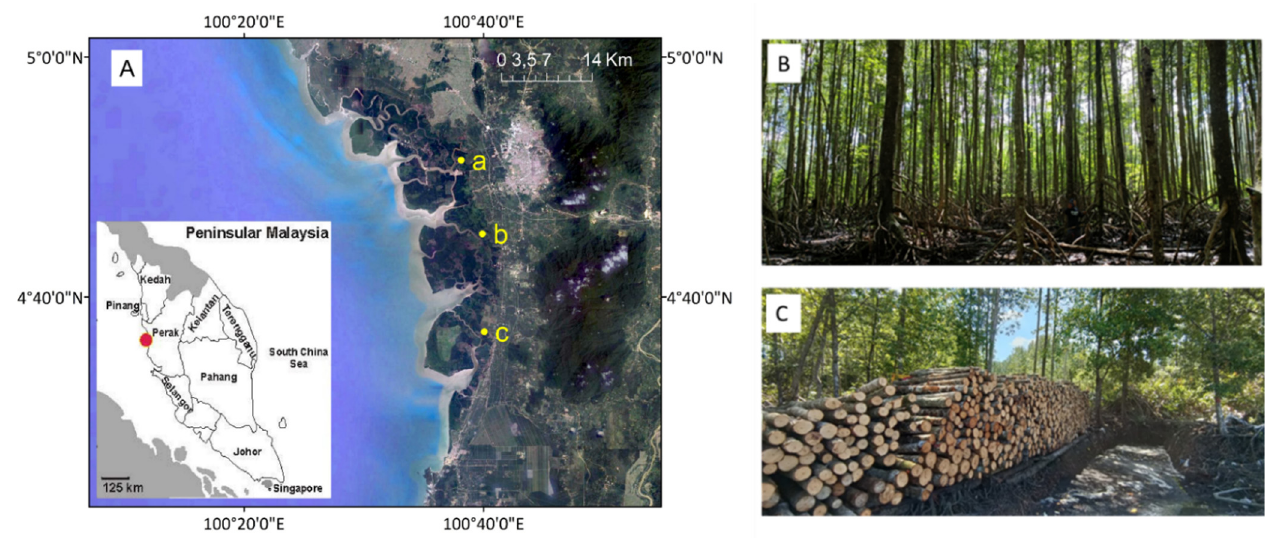
Figure 1. ( A ) Map of the Matang Mangrove Forest Reserve indicating the location of the 3 districts of Kuala Sepetang (a), Kuala Trong (b), and Sungai Kerang (c) where the charcoal factories are located. Map source: Google Earth (2018). ( B ) Carbon sequestration: protective forest stand in the Matang Mangrove Forest Reserve. ( C ) Carbon emission: Rhizophora apiculata logs from a clear-felling activity in a 30-year-old stand for the production of charcoal. Photo credit: Giovanna Wolswijk.